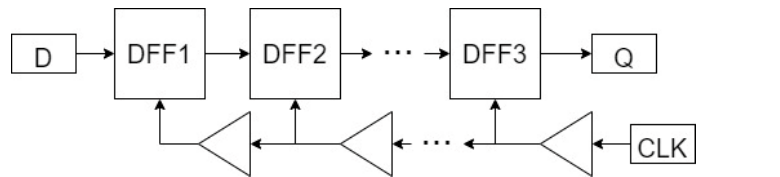
Figure 7. Flip-flop shift register chain implemented in the test chip. Clock buffers were used between each flip-flop.